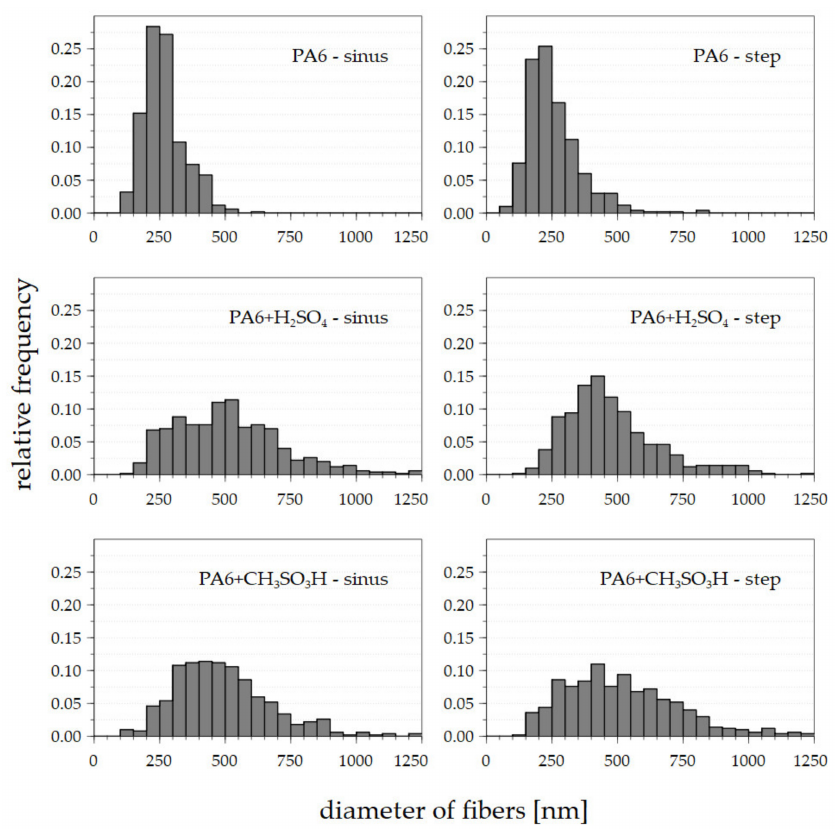
Figure 8. Histograms of the diameters of the nanofibers were created considering 500 values for each sample.